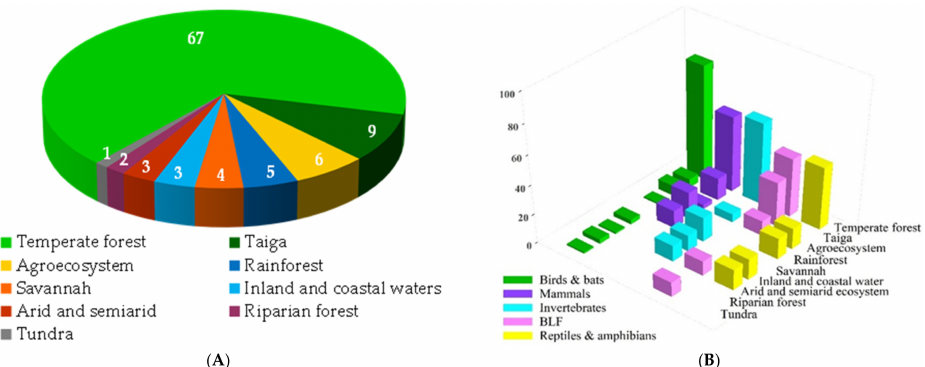
Figure 3. Percentage of articles found in the literature search dealing with LiDAR data and the studied taxonomic groups ( A ) grouped by the type of ecosystem where each study was conducted, and ( B ) arranged considering the type of ecosystem by taxonomic group. BLF: Bryophytes, lichens, and fungi; Several: studies including more than one taxonomic group. Note that the sum of percentage of studies by ecosystem within each taxonomic group is equal to 100%. See main text for more